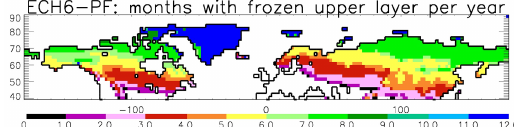
Figure 13. Number of months when in the climatological average of 1989–2009, the upper soil layer is below 0 ◦ C in